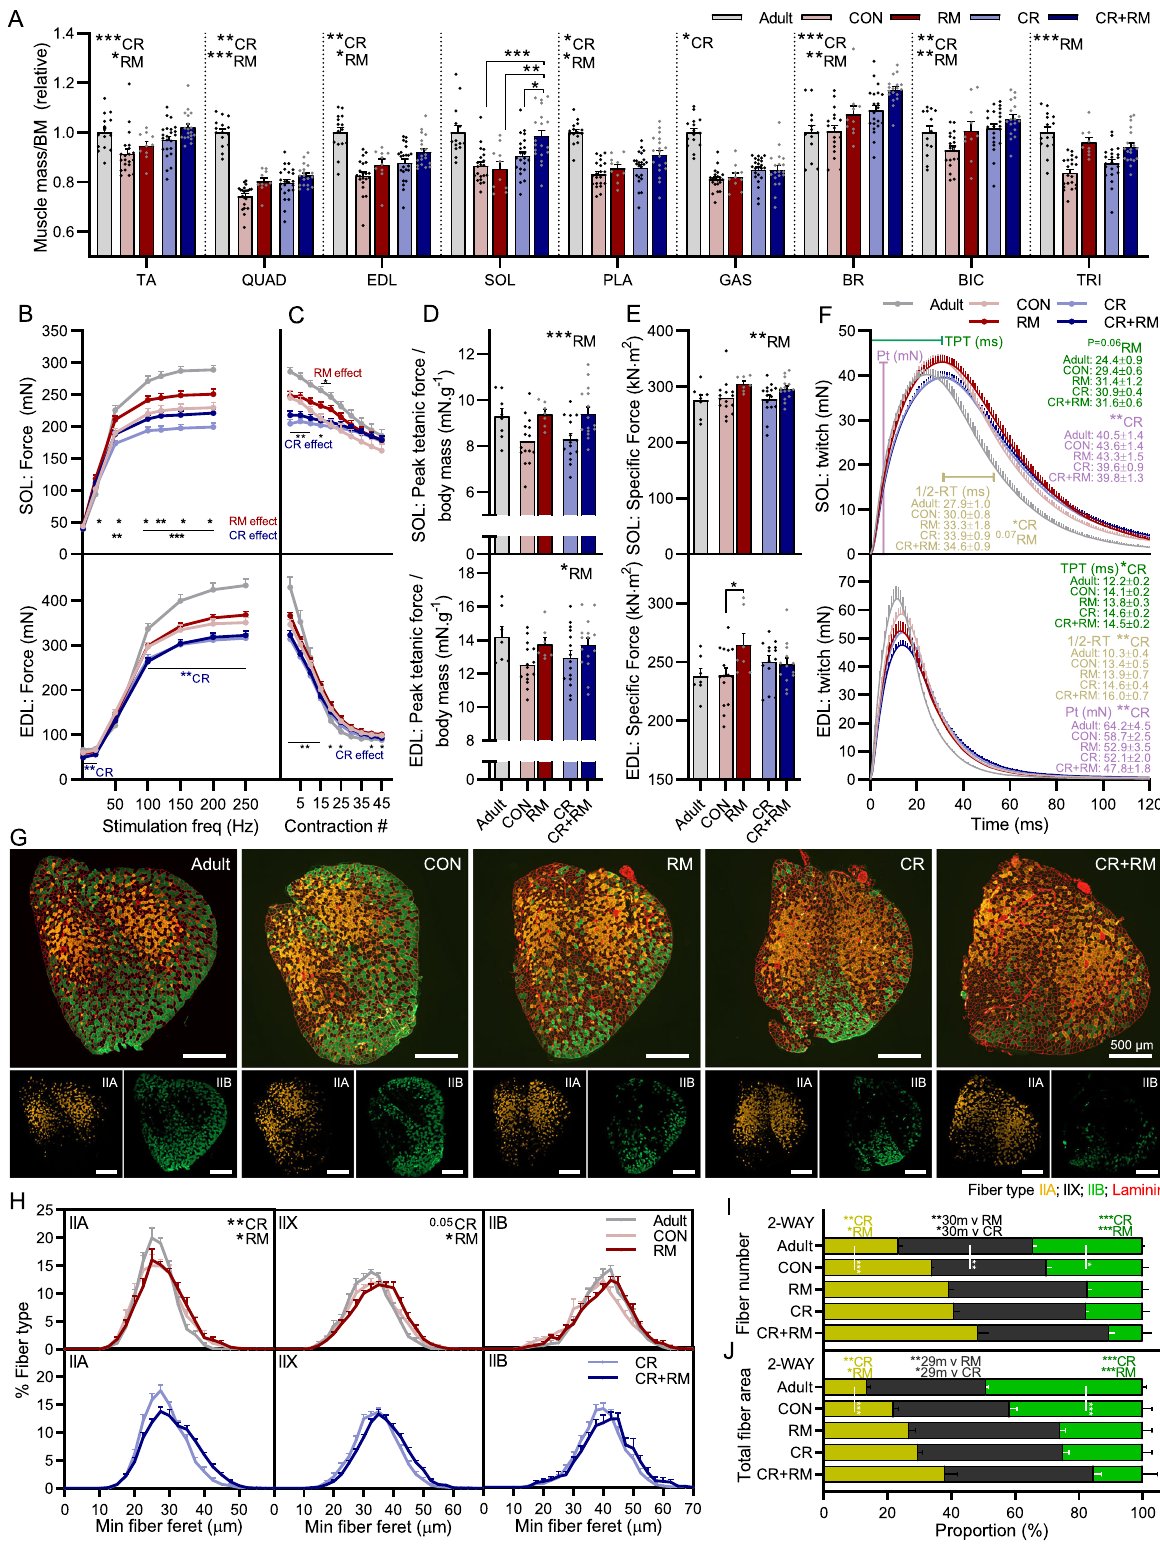
of CR to recapitulate the effects of RM raises the exciting prospect of multiple, additive interventions to counteract sar- copenia. Further work is needed to systematically isolate tar- getable processes and examine the resulting interactions in order to develop optimal strategies to counteract sarcopenia and promote healthy